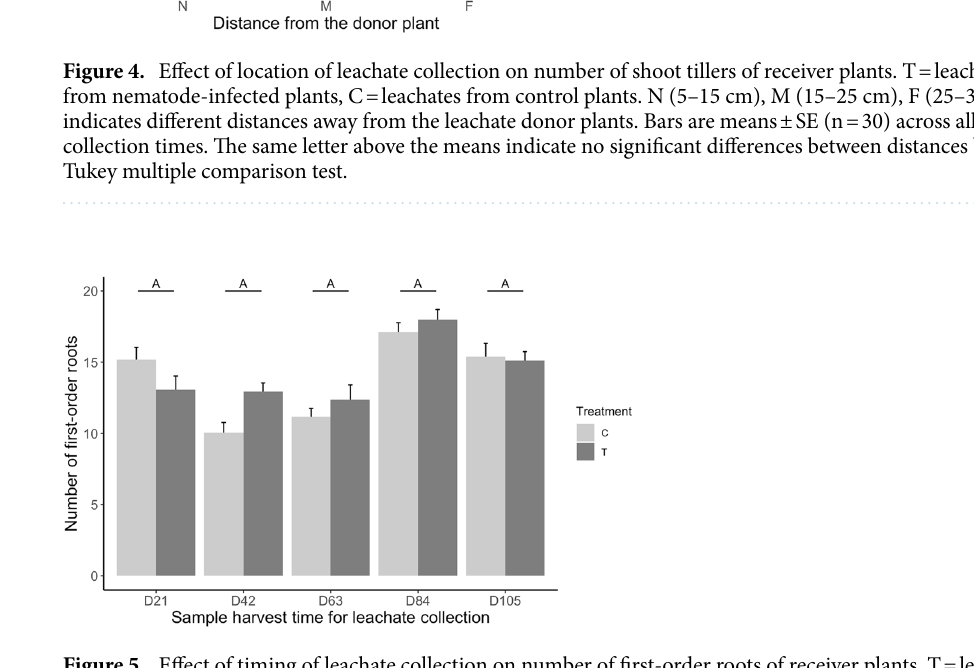
Figure 5. Effect of timing of leachate collection on number of first-order roots of receiver plants. T = leachates from nematode-infected plants, C = leachates from control plants. D21, D42, D63, D84, D105 indicate the leachate collection time in number of days (D) after nematode inoculation or water addition. Bars are means ± SE (n = 18) across all leachate collection locations. The same letter above the means indicate no significant differences between leachate collection times based on Tukey multiple comparison